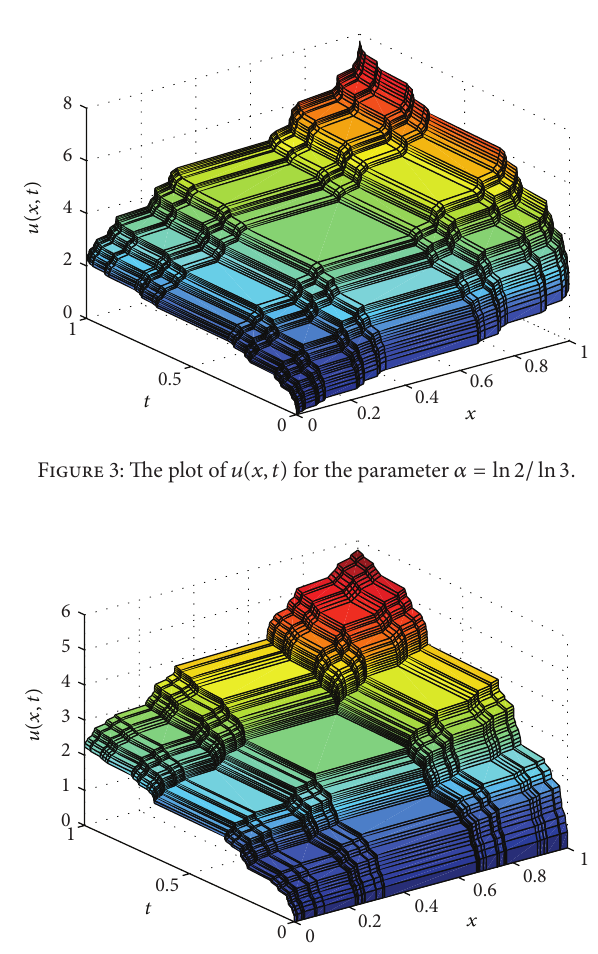
Figure 4: The plot of 𝑢(𝑥,𝑡) for the parameter 𝛼 = ln 2/ ln 3